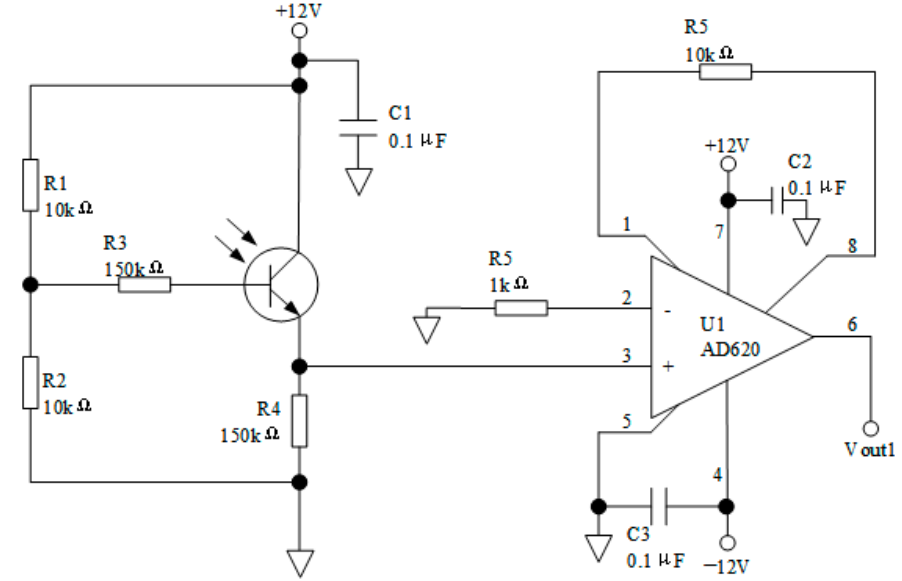
Figure 2. Circuit sketch of optoelectronic conversion for ice sensor.